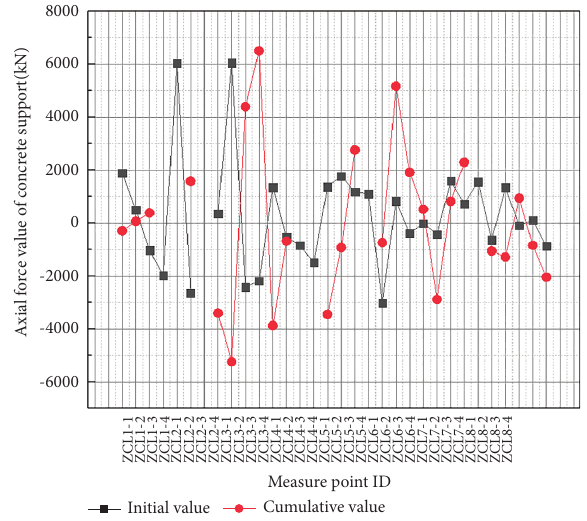
Figure 23: Variation curve of axial force of concrete support.